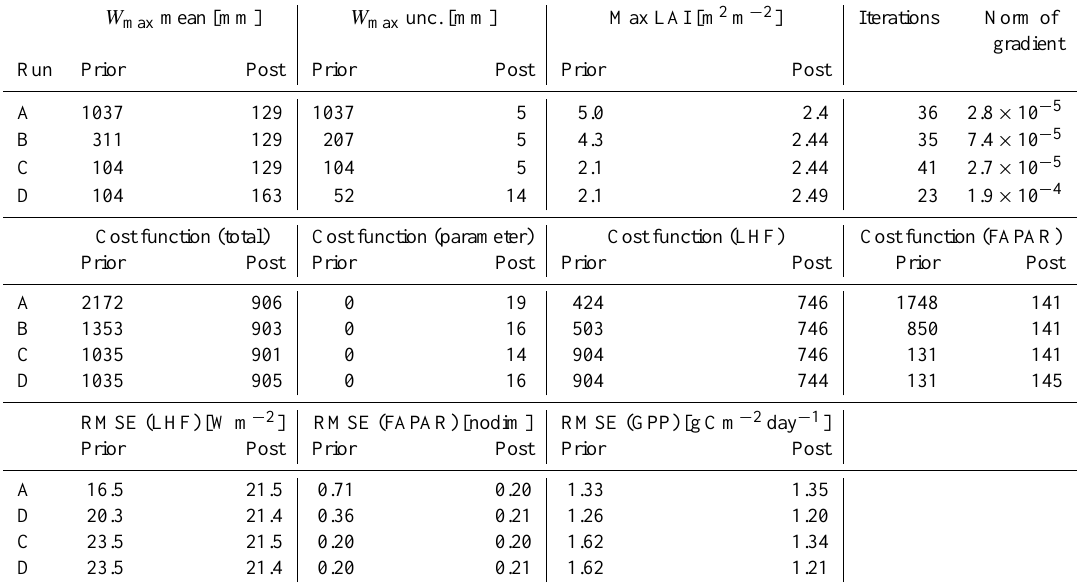
Table 4. Sensitivity analysis on the effect by a variety of prior means and uncertainties in W max to simulation results. Runs are conducted with assimilating both LHF and FAPAR simultaneously. Max LAI shows maximum leaf area index in monthly averaged value for two simulation years. C denotes the standard